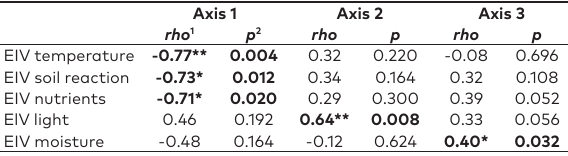
Table 2. Significance of Spearman’s rank correlation of mean EIVs with three main PCoA axes within the tall-herb communities in the Sudetes Mts. and their foothills using modified permutation